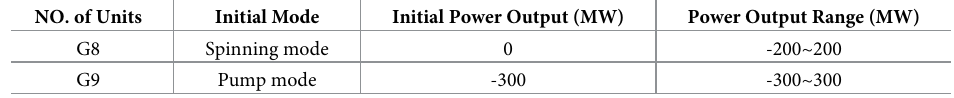
Table 1. Initial parameters of the pumped storage units in the EPRI-36 bus